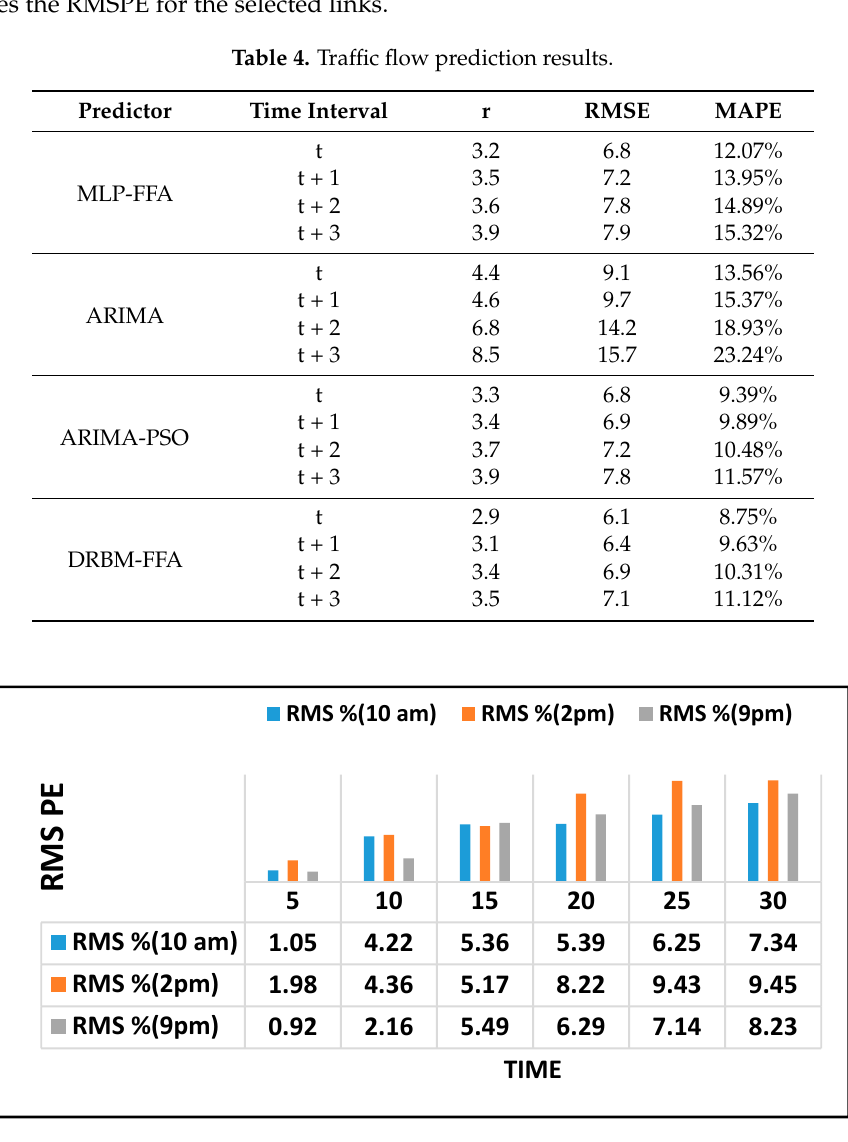
Figure 7. RMSPE for the targeted links.